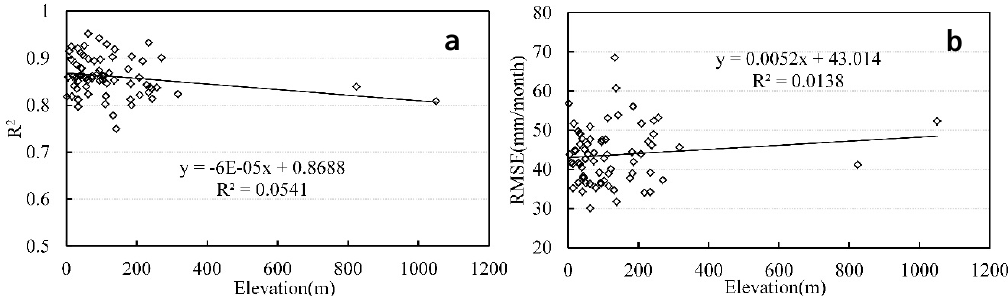
Figure 12. Scatter plots of statistical indices versus elevation for TRMM 3B43, with ( a ) for R 2 ; ( b ) for RMSE .